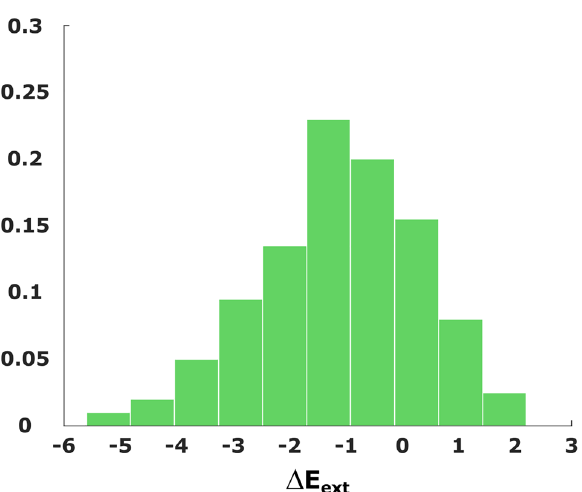
Figure 10. Histogram of the forward driving signals using an inverted Mexican hat (10) with σ = 4 as sensorimotor loss. Because of unexpected bias towards negative values of the driving signal we observe, it is unlikely the data was generated by a a Markov chain following such a sensorimotor loss and we can discard this model. Note we observe the same bias in the backward driving